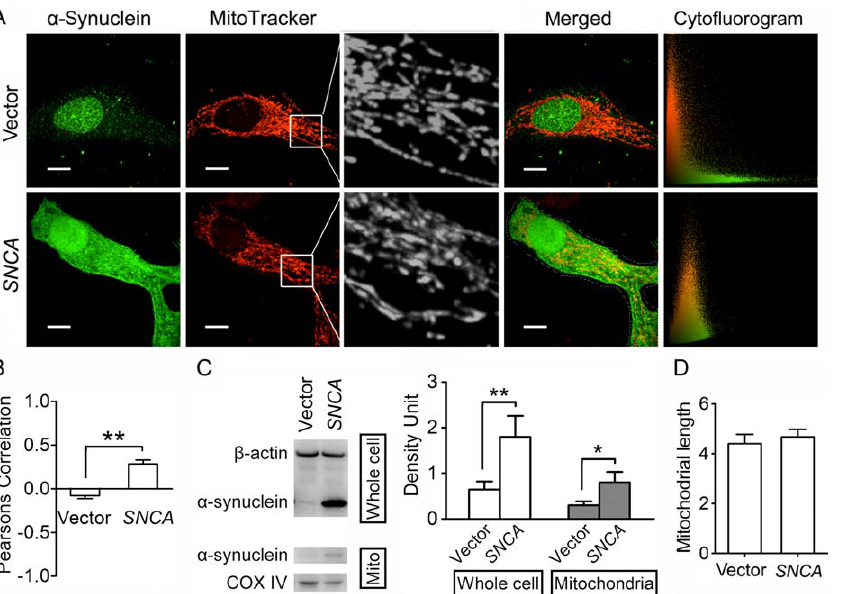
Figure 5. a -Synuclein overexpression in Hela cells promotes its co-localization with mitochondria without affecting mitochondrial morphology. A. Representative double-staining images of a -synuclein (Green) and mitochondria (Red) in Hela cells transfected with SNCA or an empty vector for 48 h. Further amplified images show that no obvious change in mitochondrial morphology between these two groups. Cytofluorogram analysis demonstrates that PC coefficient in that a -synuclein overexpressed cell is remarkably elevated (PC=0.374221, CC Mx=0.998574, CC My=0.845116) compared with Vector group (PC= 2 0.0338751, CC Mx=0.905173, CC My=0.796768). Scale bars for 10 m m. B. Quantitative analysis demonstrates that PC coefficients in SNCA group are much higher than Vector group. C. Immunoblotting assay demonstrates that a -synuclein expression levels in Hela cell lysates and mitochondrial lysates are both remarkably increased after SNCA transfection for 48 h (n=4). D. Quantitative analysis of changes in mitochondrial length shows no significant statistic difference between SNCA group and Vector group. Images of 20 cells from each group were processed for cytofluorogram (B) and mitochondrial morphology analysis (D), and the experiment was repeated three times. *P , 0.05, **P , 0.01.